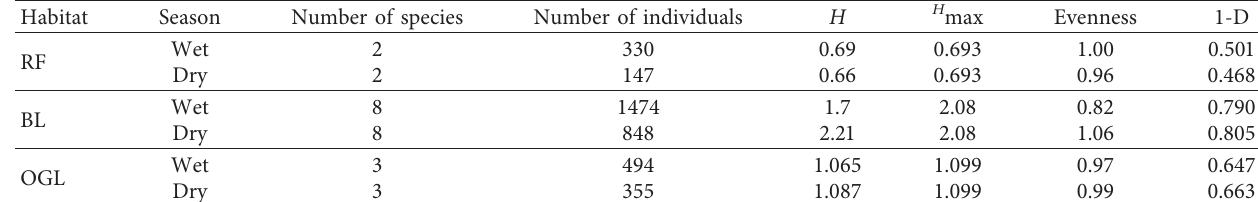
Table 6: Diversity indices of mammals in the three habitats during both